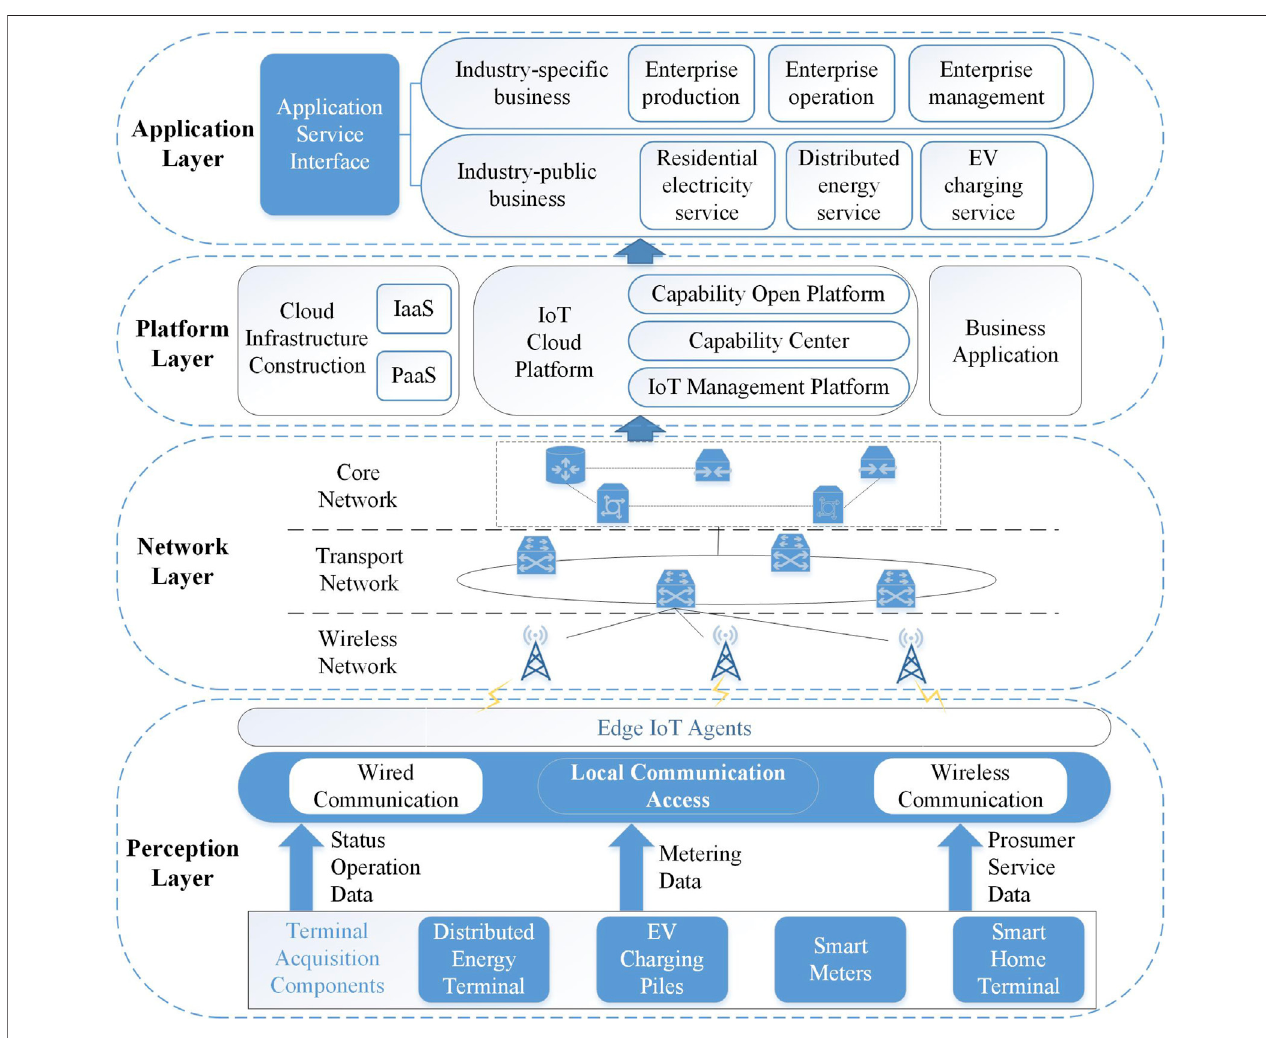
FIGURE 1 | Hierarchical architecture of